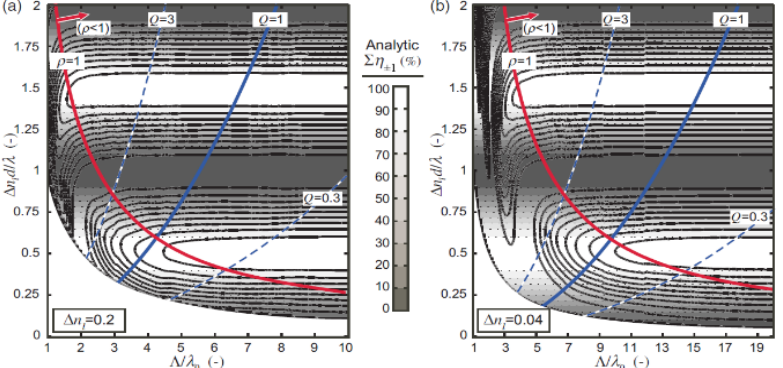
Figure 8. A comparison between numerical finite difference time domain (FDTD) calculation and analytical estimate is shown for ( a ) ∆ n = 0.2 and ( b ) ∆ n = 0.04, respectively [18]. Copyright 2007, The American Physical Society.